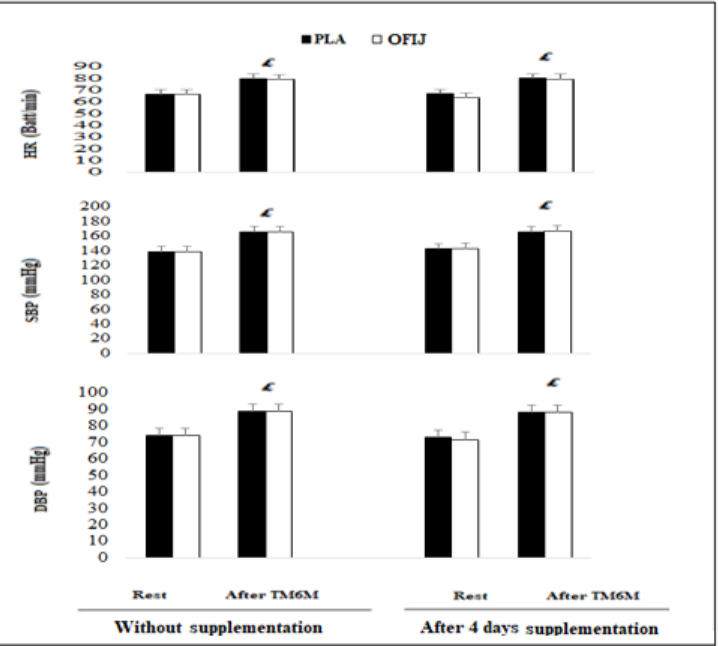
Figure 3. Cardiovascular parameters (mean ± SD; n = 20) recorded before and after the 6MWT without and with supplementation of PLA and OFIJ. £: significant difference compared to before the 6MWT ( p < 0.05).